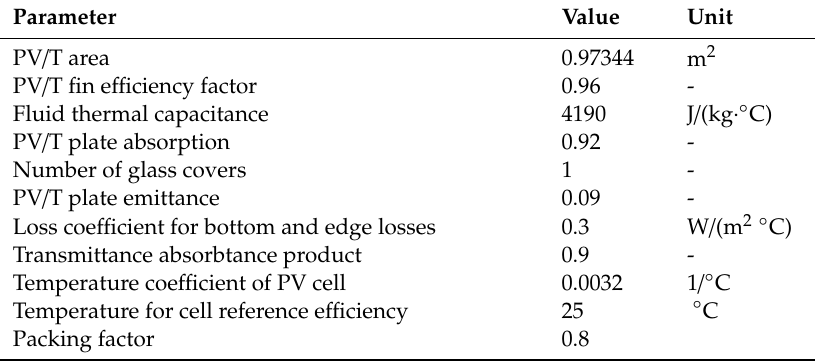
Table 3. Depiction of the low-concentrating photovoltaic / thermal (LCPV / T)